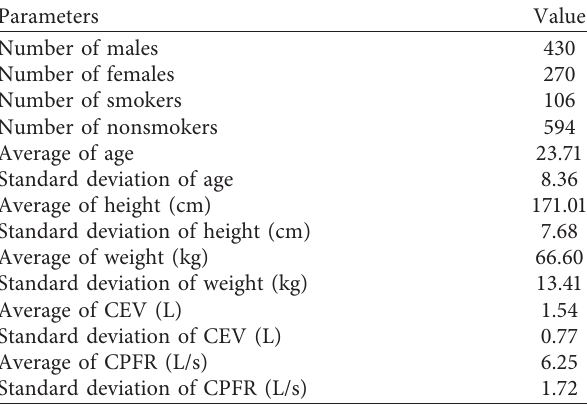
Figure 6: The operation process of GA-BP. The GA-BP starts with GA which optimizes the initial values of weight and threshold of the BP neural network. Then, the BP neural network begins training with the optimized weights and thresholds until the end condition is satisfied. Table 1: Statistical results of data for 700